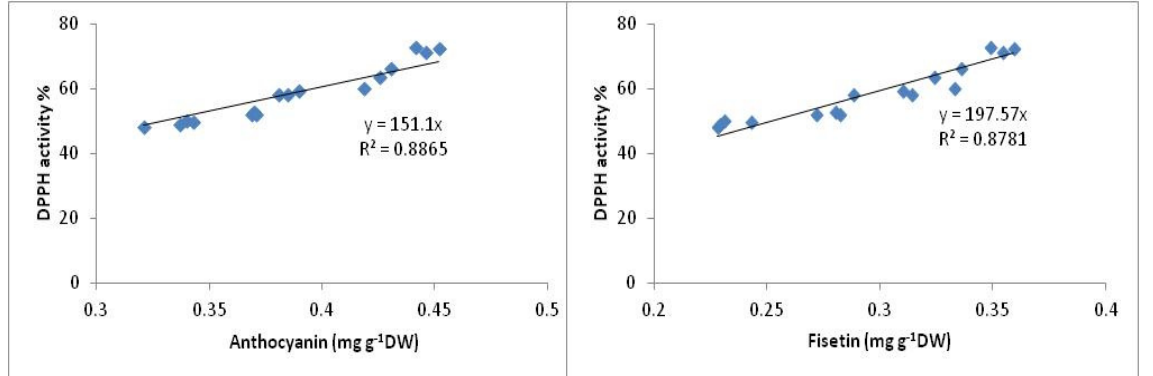
Figure 4. Relationship between anthocyanin and fisetin with DPPH activity in ginger